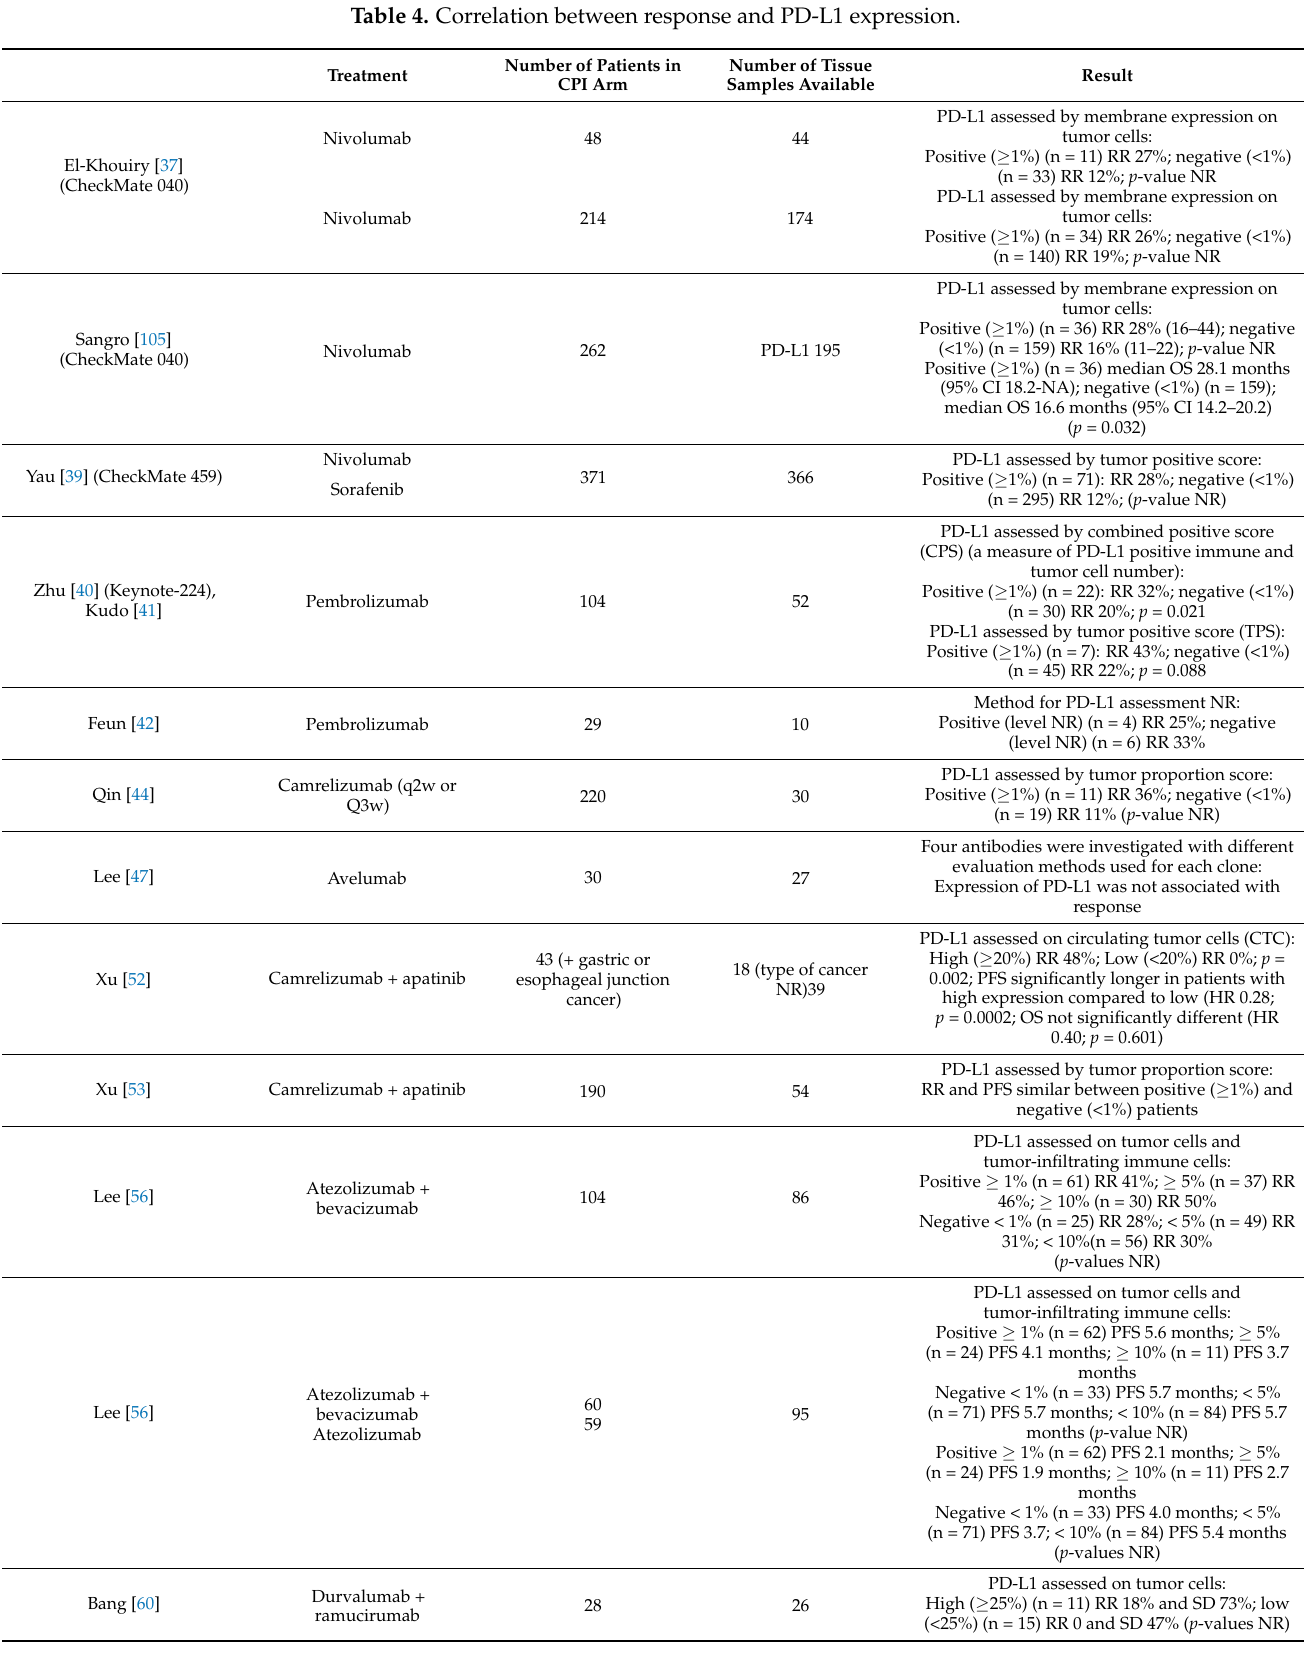
Table 4. Correlation between response and PD-L1 expression.